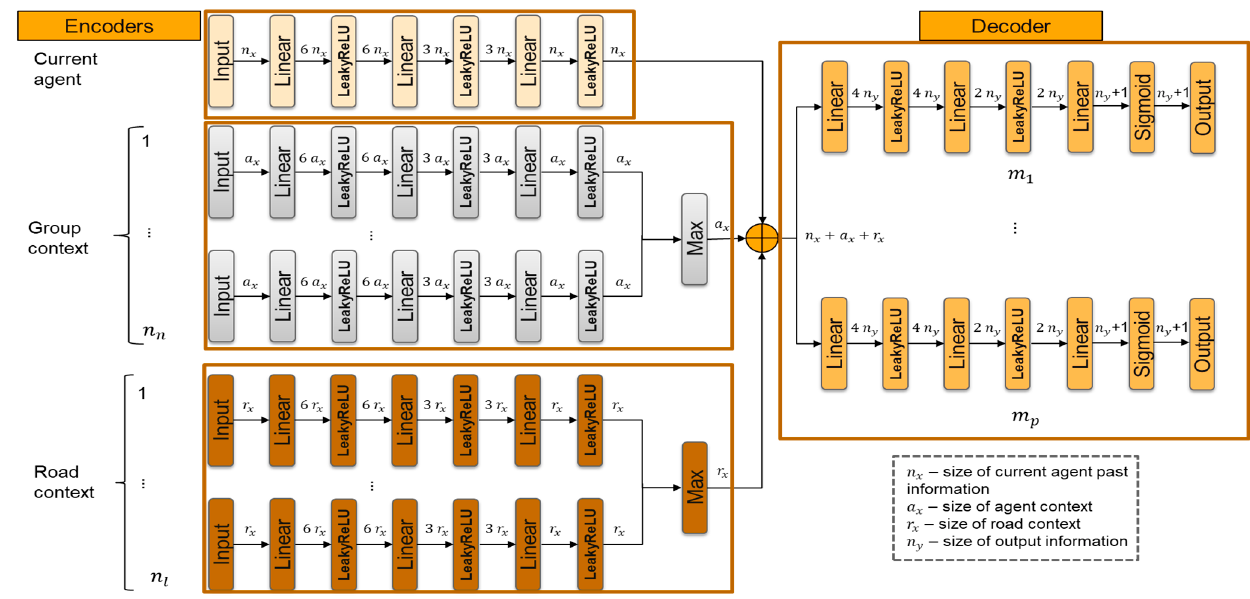
Figure 8. The architecture of the neural network.